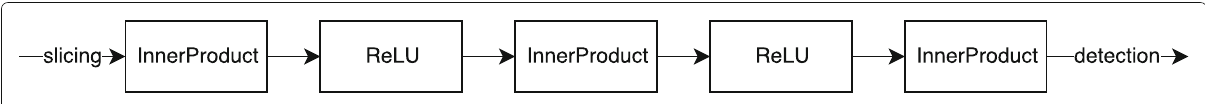
works, timbre robustness results, and AMT results are given in the end of this section.